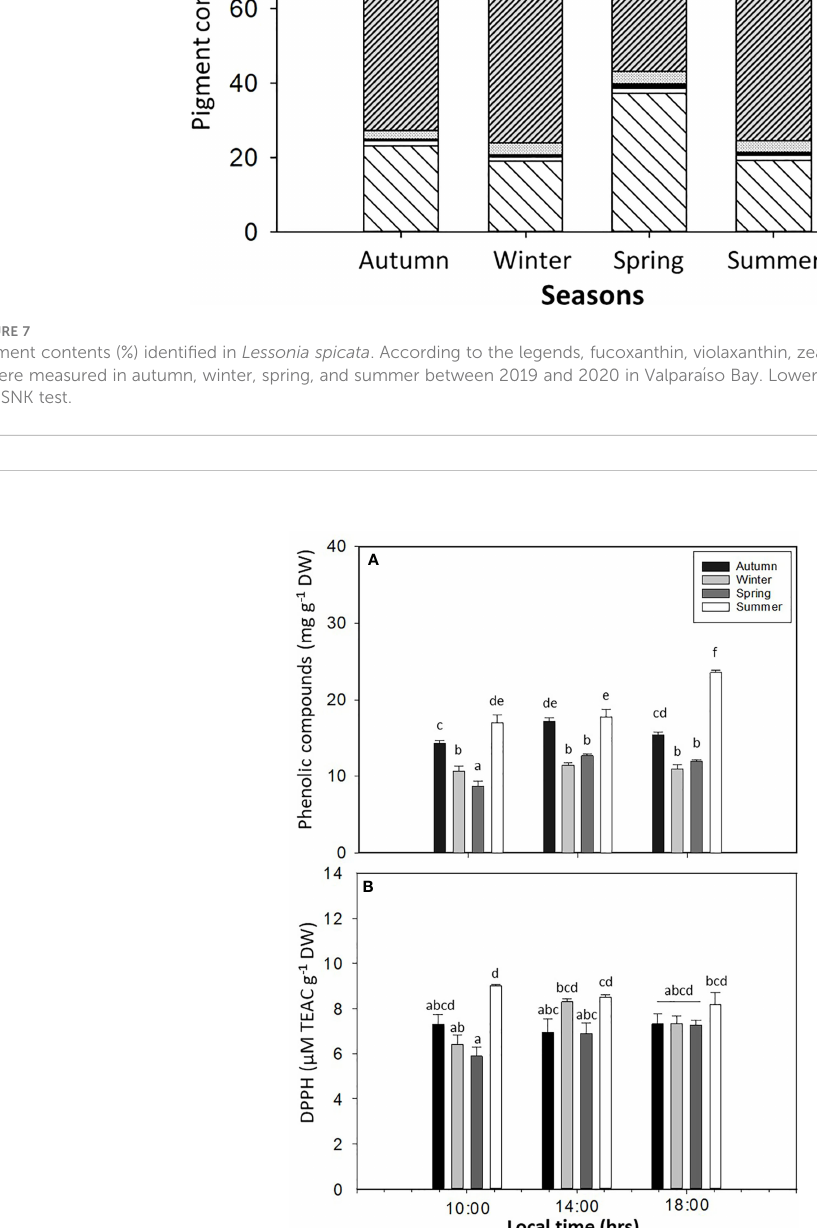
FIGURE 8 (A) Phenolic compounds and (B) DPPH antioxidant method in Lessonia spicata under daily cycle experiments in autumn, winter, spring, and summer between 2019 and 2020 in Valpara ı ́ so Bay. Lower - case letters denote signi fi cant after the SNK